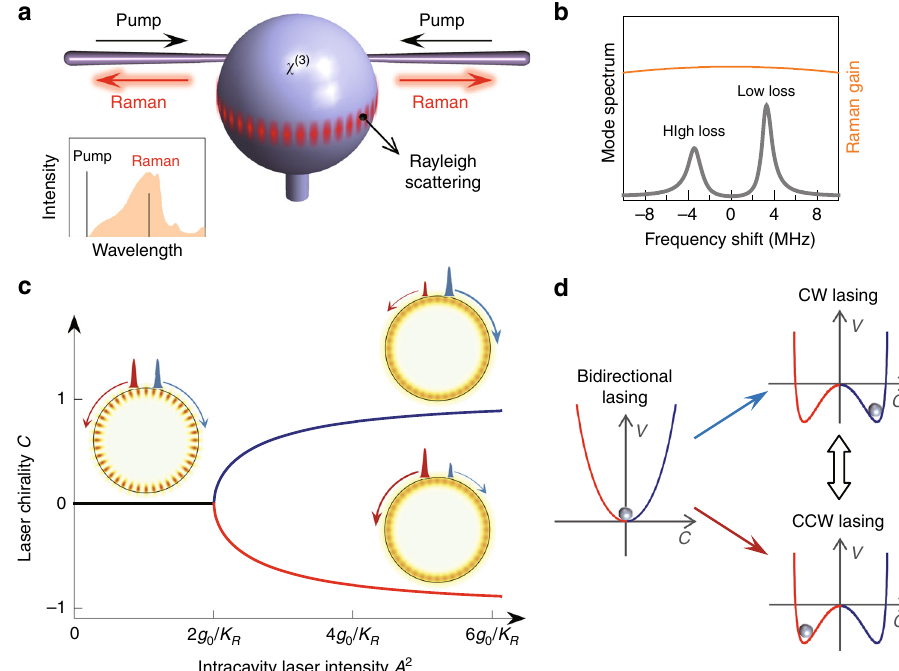
Fig. 1 Schematic of the spontaneously symmetry-broken microlaser. a Illustration of the Raman laser in a microsphere, where the intracavity counter- propagating laser fi elds are coupled through linear Rayleigh scattering and nonlinear Kerr phase modulation. Inset: Schematic optical spectra of a Raman laser process. The orange shade denotes the Raman gain curve. b Mode competition of two Raman supermodes induced by the linear intrinsic coupling, where the gray curve is the Raman supermodes spectrum, and yellow curve represents the nearby Raman gain. Here only the high-frequency mode can lase due to the lower mode loss. c Laser chirality vs. intracavity Raman laser intensity, exhibiting a pitchfork bifurcation with the corresponding visualization of the laser- fi eld distribution. d Dependence of the effective potential V on the laser chirality C . The red (blue) branch denotes the CCW (CW) chiral